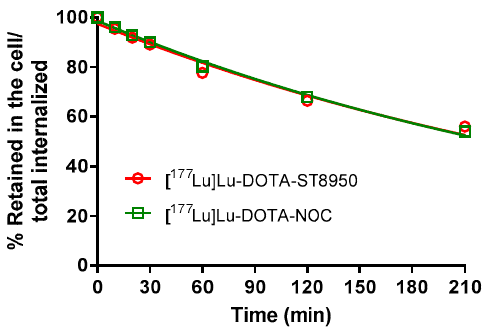
Figure 3. Cellular retention of [ 177 Lu]Lu-DOTA-ST8950 and [ 177 Lu]Lu-DOTA-NOC in HEK-SST2 after 2 h of incubation at 37 °C and acid wash to remove the cell-surface-bound fraction. The results are expressed as % (mean ± SD) of the internalized activity.